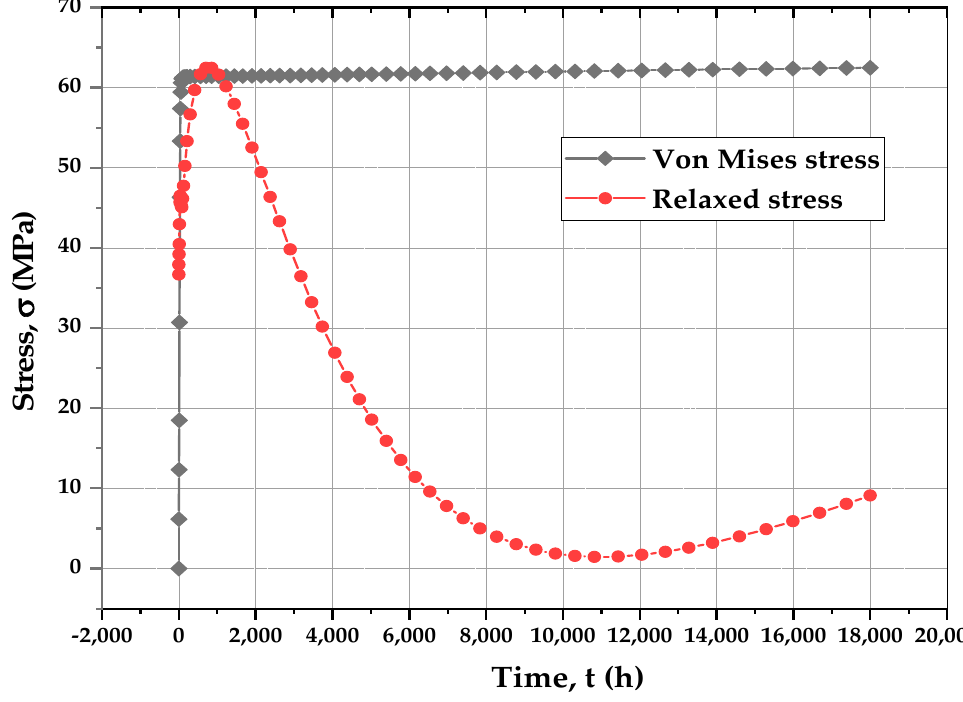
Figure 5. Von Mises stress and relaxed stress distribution with Omega–Norton–Bailey Regression model’s visco-elastic–plastic run-time of 18,000 h.